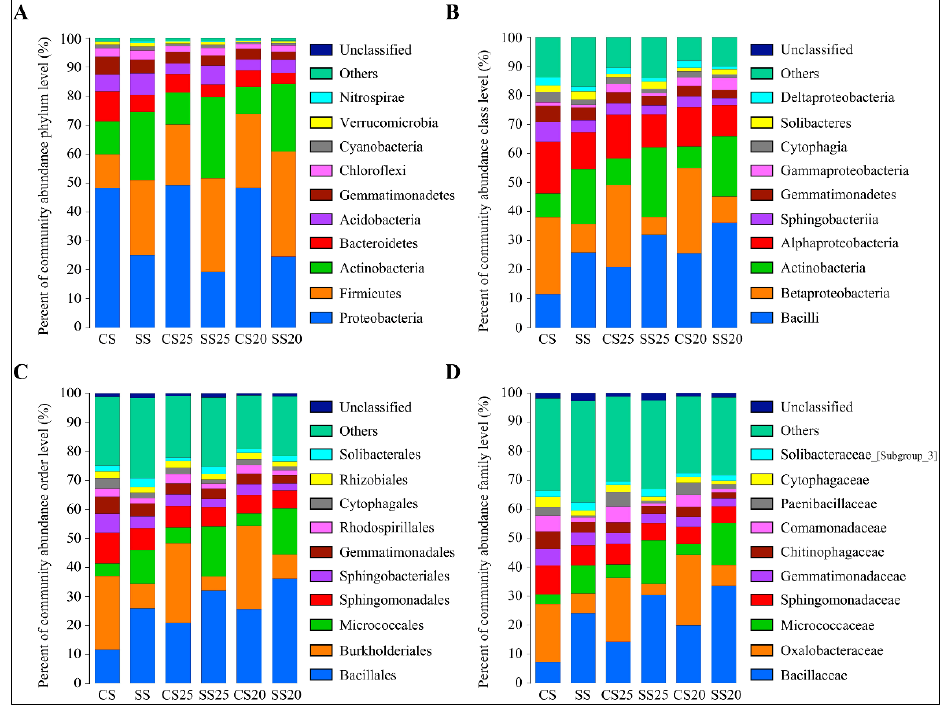
Figure 2. Bacterial community structure in the peanut spermosphere soils and the bulk soils at the phylum, class, order, and family level. ( A ) Percent of taxa at the phylum level in the peanut spermosphere soils and the bulk soils. The relative abundance was calculated by averaging the abundances of three duplicates in each soil group. ( B ) Percent of taxa at the class level in the peanut spermosphere soils and the bulk soils. The relative abundance was calculated by averaging the abundances of three duplicates in each soil group. ( C ) Percent of taxa at the order level in the peanut spermosphere soils and the bulk soils. The relative abundance was calculated by averaging the abundances of three duplicates in each soil group. ( D ) Percent of taxa at the family level in the peanut spermosphere soils and the bulk soils. The relative abundance was calculated by averaging the abundances of three duplicates in each soil group.